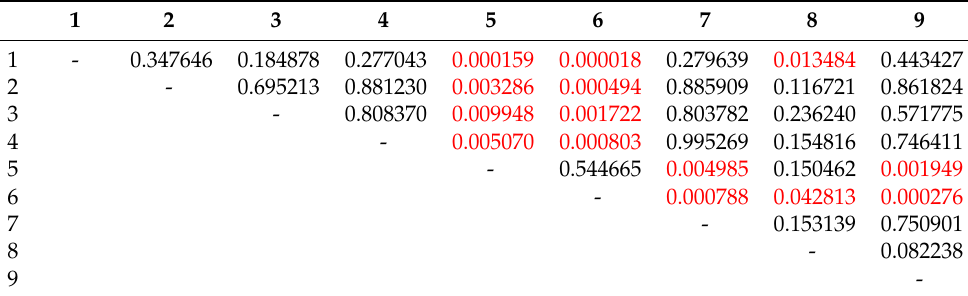
Ageing protocols: control-water, 24 h, 37 ◦ C; thermocycling + NaOH-water, 7500 thermo cycles, 5/55 ◦ C and 0.1 M NaOH, 7 days, 60 ◦ C; 5d water + NaOH-water, 5 days, 55 ◦ C and 0.1 M NaOH, 7